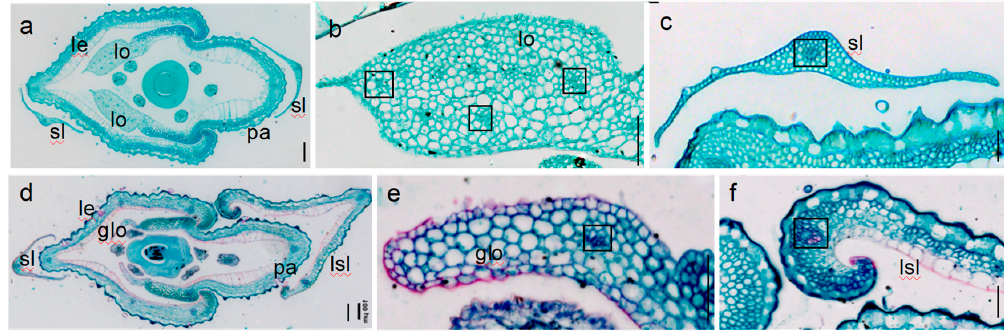
Figure 2. Histological analysis of spikelet at flowering stage in the wild-type and noh1 plants; ( a – c ) the cross-sections of the wild-type spikelet; ( d – f ) the cross-sections of the noh1 spikelet. glo: glume-like lodicule; lsl: lemma-like sterile lemma; le: lemma; lo: lodicule; pa: palea; sl: sterile lemma; (cid:3) : vascular bundle; bars represent 100 µ m ( a , d ) and 50 µ m ( b , c , e , f ).